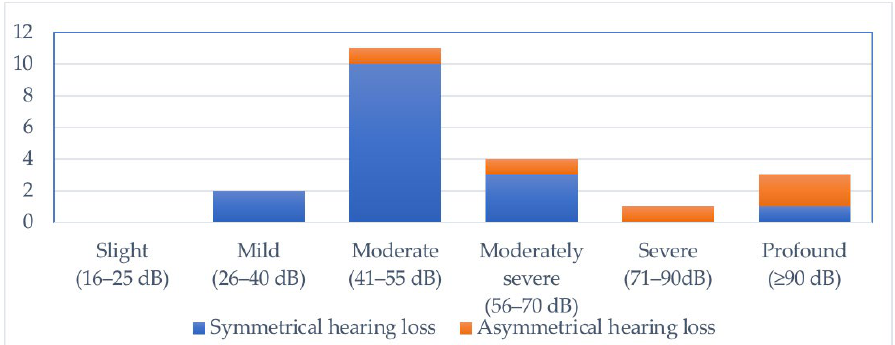
Figure 1. Severity of hearing loss for the included patients.